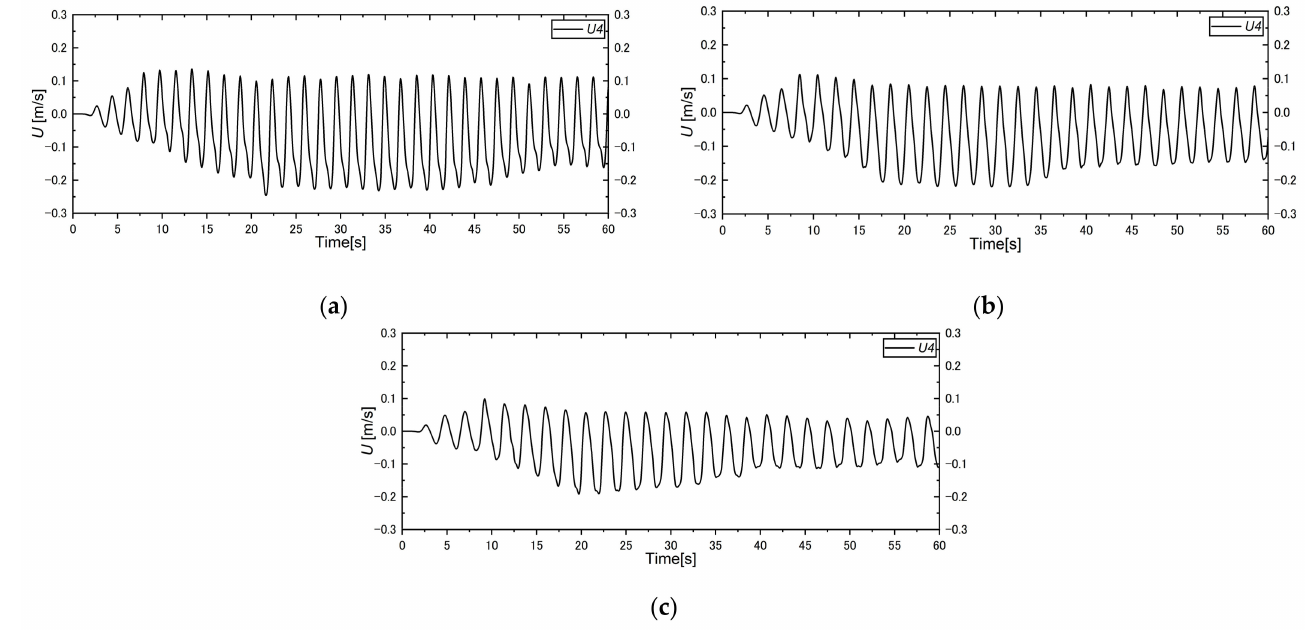
Figure 14. Cross-shore flow velocity at U4 ( r = 336 cm) in ( a ) case 1 (T-1.80 s), ( b ) case 2 (T-2.0 s), and ( c ) case 3 (T-2.25